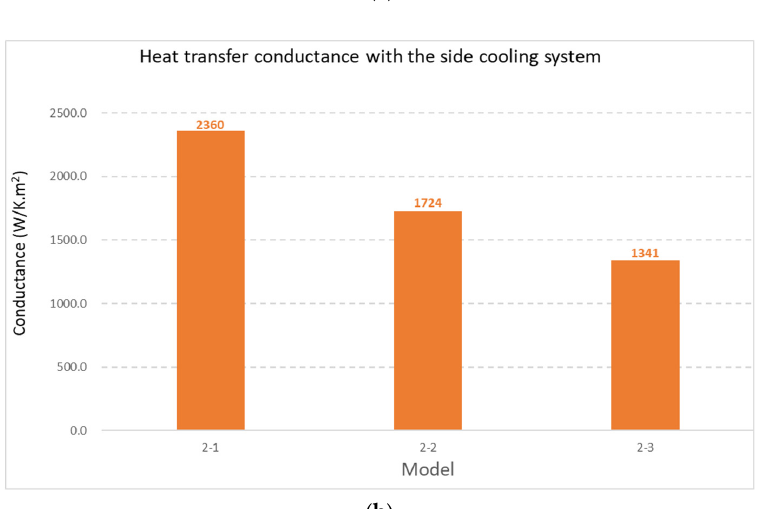
Figure 13. Heat transfer conductance for the bottom ( a ) and side ( b ) cooling